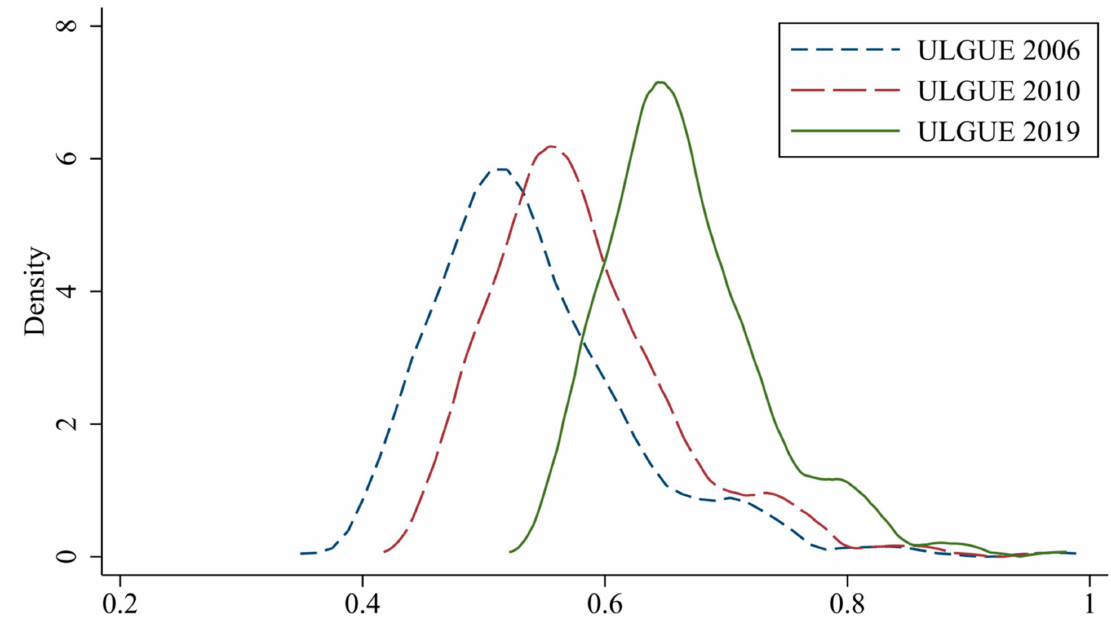
Figure 4. Dynamic temporal evolution characteristics of